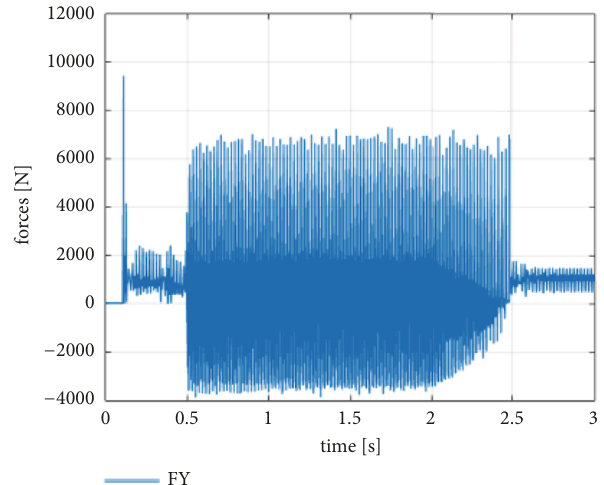
Figure22:Predictedrotorverticalforcesduringaradiallandingtest (DE node).